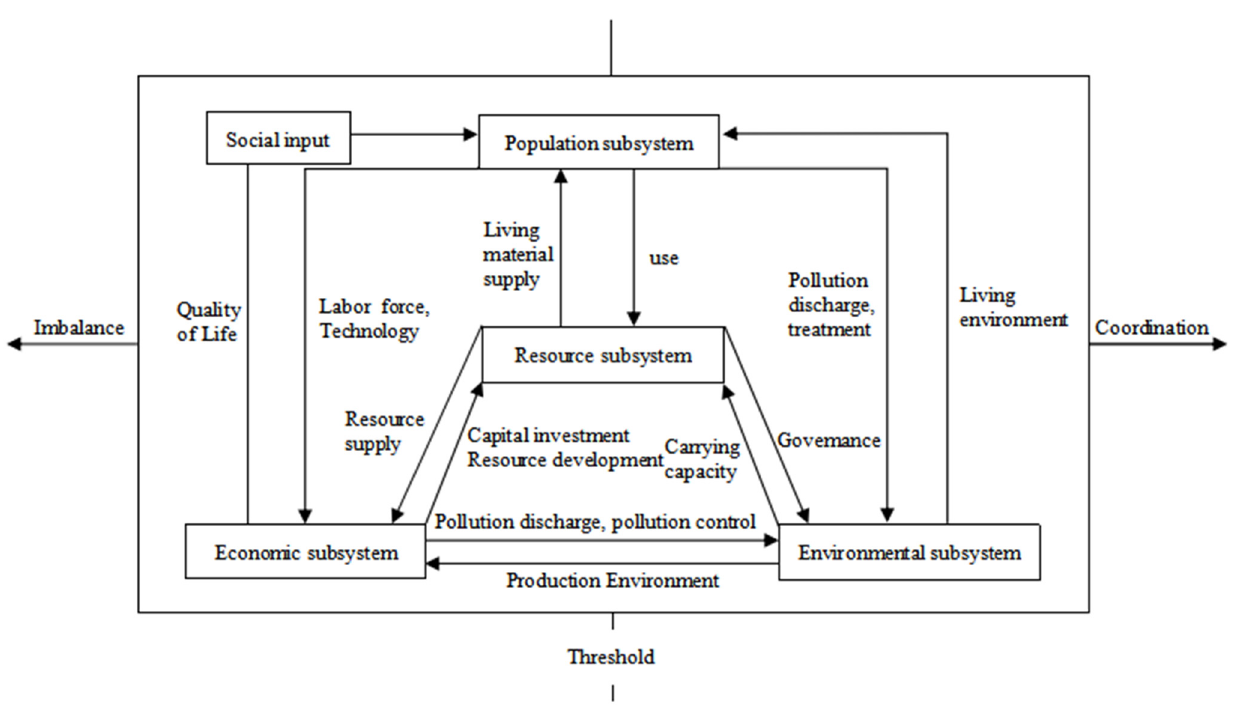
Figure 1. PREE system operating mechanism structure diagram. Source: modified based on Figure 1 in Zeng et al. [1].